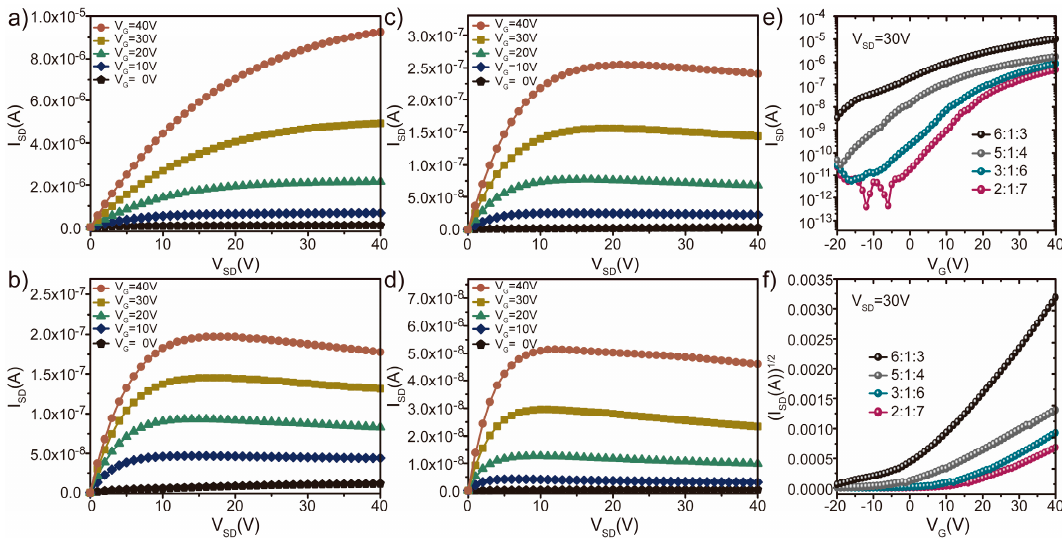
Figure 2. ( a , d ) Output characteristics of InGaZnO thin-film transistors (TFTs) with different molar ratios of the elements, namely In:Ga:Zn ratios of 6:1:3 ( a ), 5:1:4 ( b ), 3:1:6 ( c ), and 2:1:7 ( d ). ( e , f ) Transfer characteristics of the InGaZnO TFTs. The channel length, width, and thickness of the above TFTs are about 60 µm, 300 µm, and 40 nm, respectively.